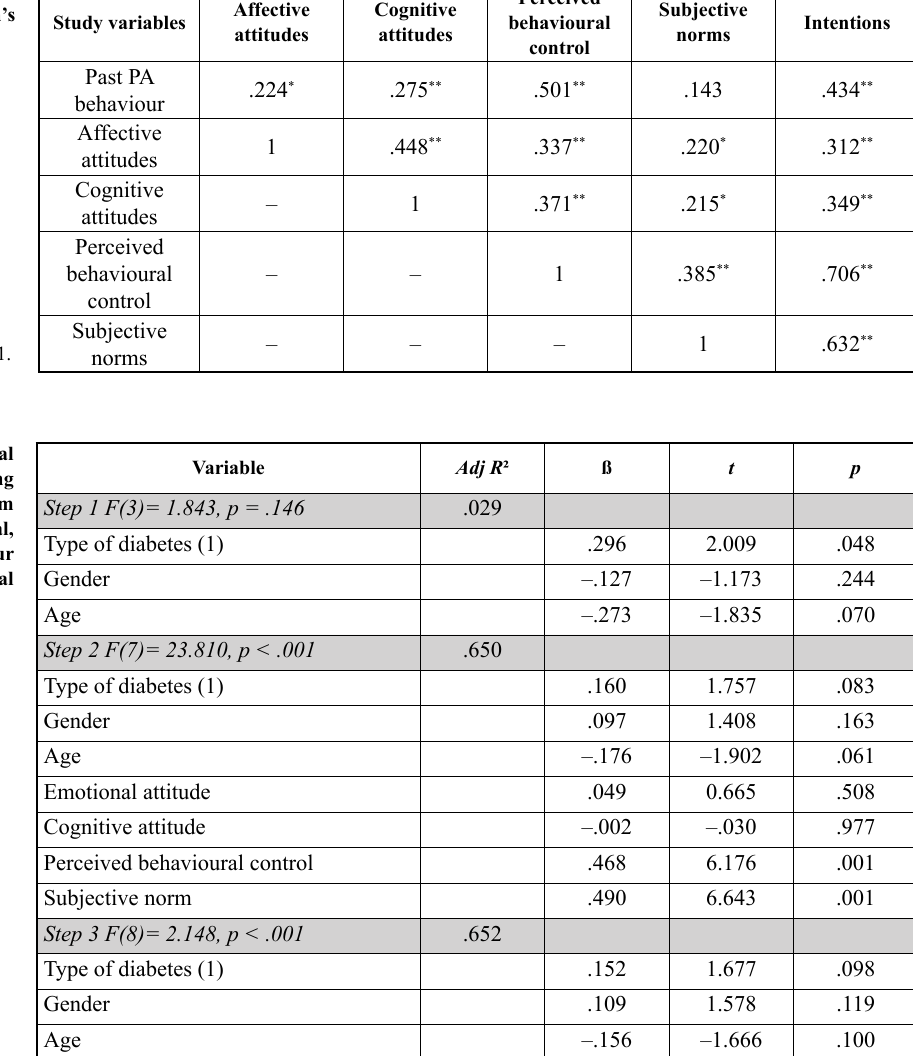
Table 2. Correlations between the study variables (Pearson’s coefficient)